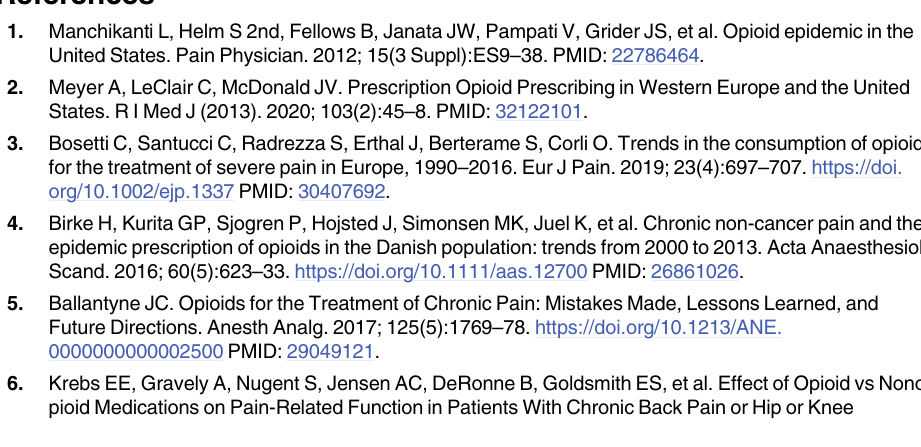
S2 Table. Top 10 diagnoses of OOH contacts with > = 1 opioid prescription in Flanders and the Netherlands in 2018. S3 Table. Sex and age distribution of patients with an opioid prescription at the OOH-PCS, in Flanders and the Netherlands in